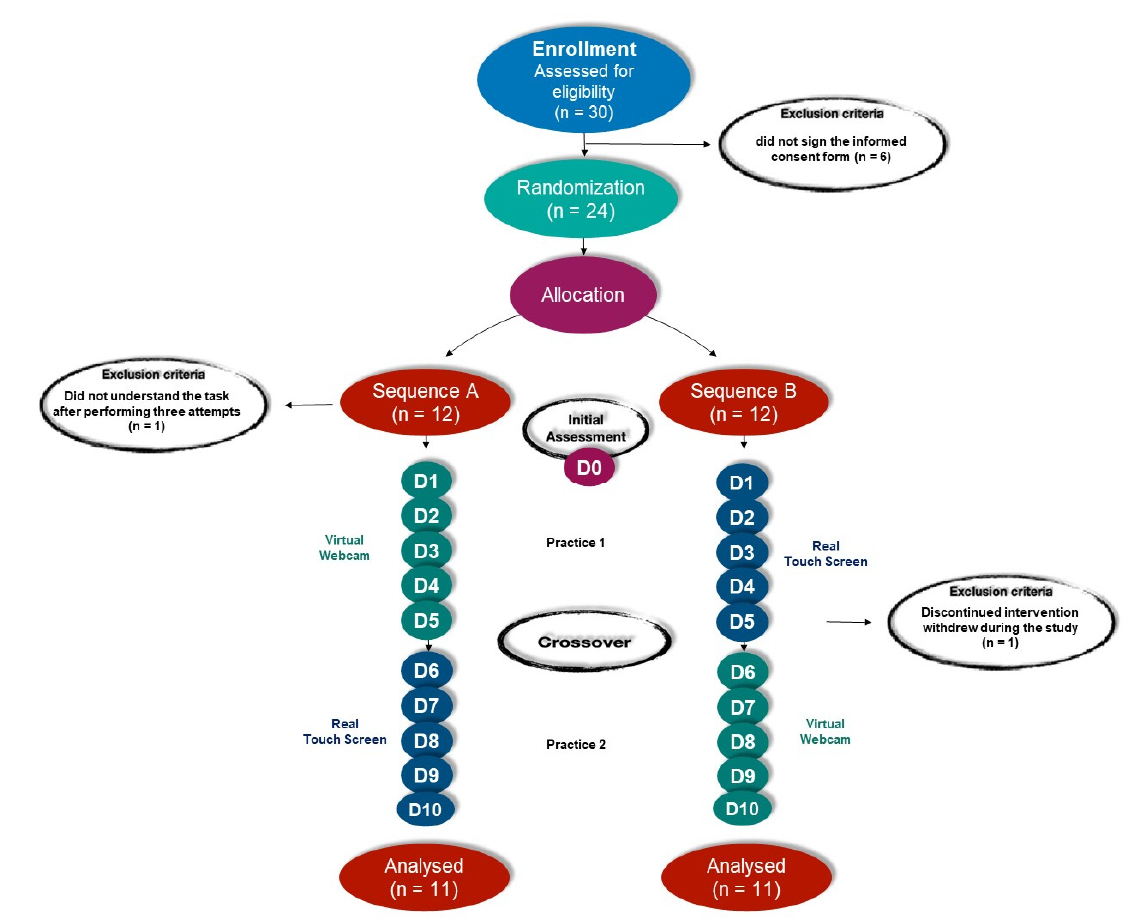
Figure 2. Study design (D1–D5: Days of intervention).